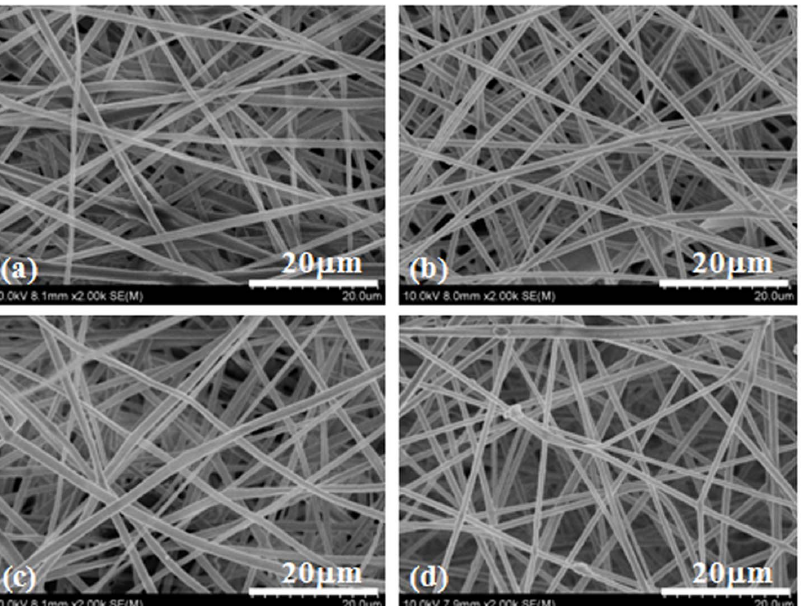
Figure 2. SEM images of electrospun fibers. PLLA fibers (a), PLLA-2% (b), PLLA-6% (c) and PLLA-10% (d) with 0%, 2.0%, 6.0% and 10.0% Rg3, respectively.